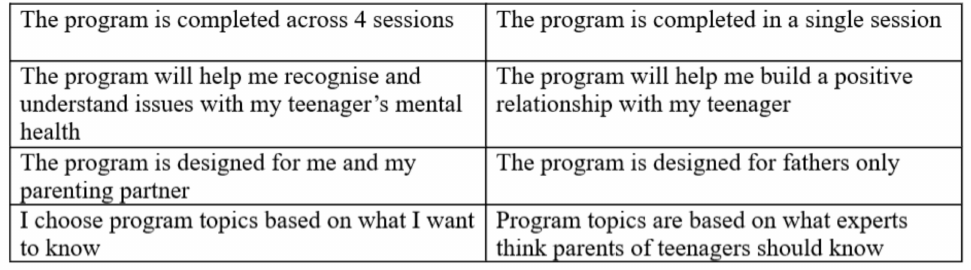
Figure 1. DCE scenario and example choice